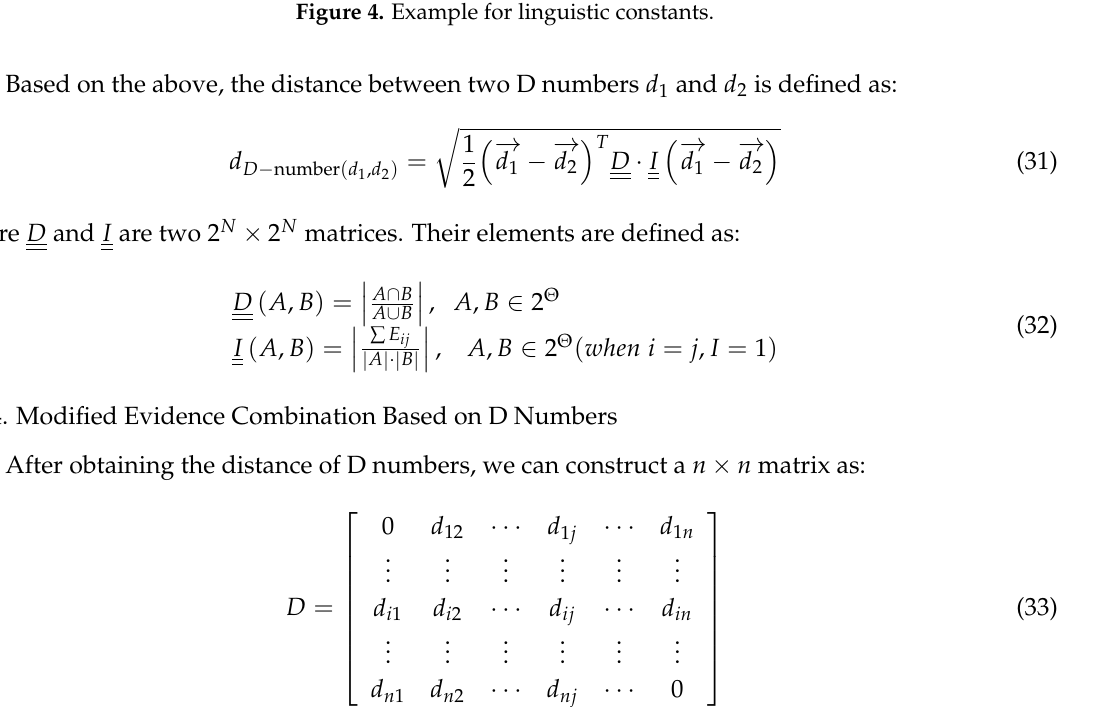
Figure 4. Example for linguistic